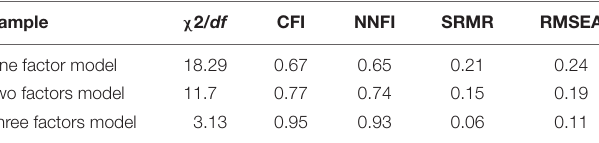
TABLE 2 | Fit indexes for the three-factorial models.